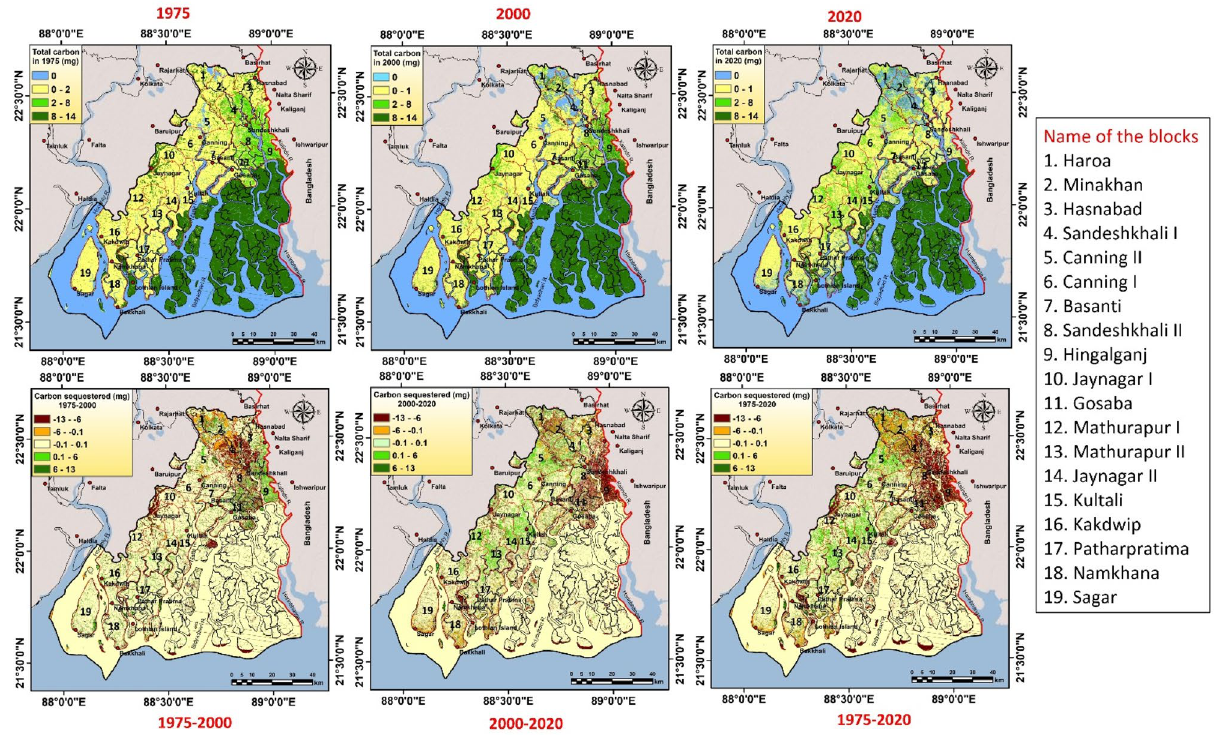
Figure 5. Total carbon stock amount (mg/ha) in the year 1975, 2000 and 2020 along with carbon sequestered from 1975 to 2000, 200 to 2020 and 1975 to 2020. The maps were prepared using ArcGIS 10.3 software [https:// deskt op. arcgis. com].